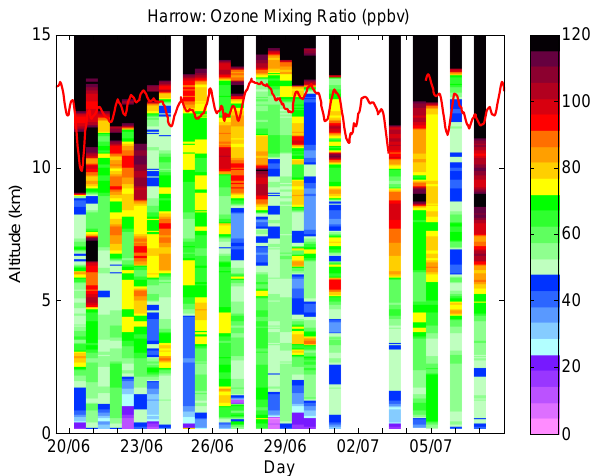
Figure 3: Vertical profiles of ozone mixing ratios from a GEM-FLEXPART simulation, at the location of the Harrow site in the summer of 2007. The red solid line shows the tropopause height derived from the radar data, and the white lines (dotted and solid) show the (first and second) tropopauses derived from the potential vorticity distribution estimated in the GEM model. Date and time are UTC.